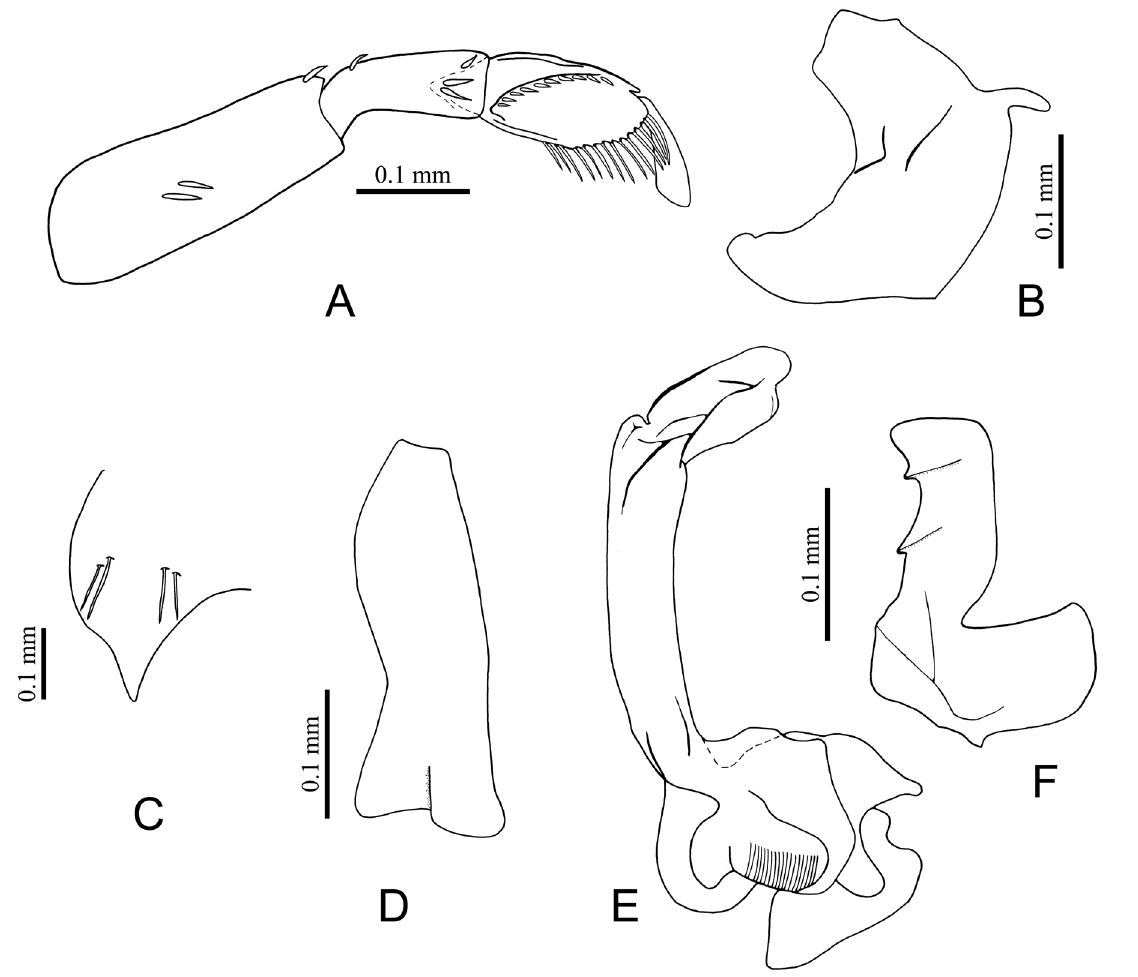
Fig. 17. Morphological features of Micronecta undulata sp. nov., ♂, paratype (ZVNU). A . Fore leg. B . Prestrigilar flap. C . Median lobe of sternite VII. D . Free lobe. E . Right paramere. F . Left